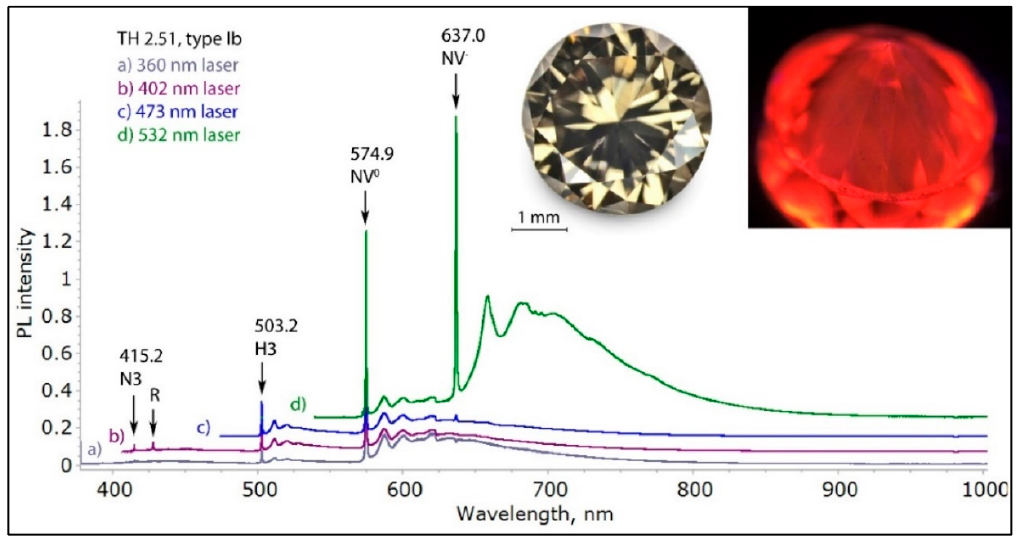
Figure 18. The low temperature PL spectra of a very rare brown low nitrogen type Ib diamond with a deformation-related color, recorded with four different laser excitations. The spectra of such diamonds are always dominated by NV 0 and NV − centers, combined with the H3 defect. In this diamond, the NV 0 defects are responsible for the red orange fluorescence seen in the photo (inset, right). The spectra were shifted vertically for clarity.